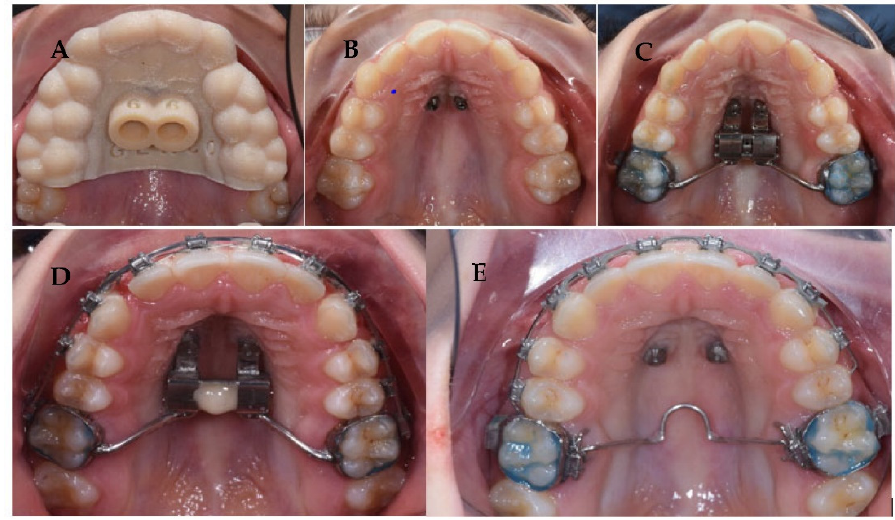
Figure 11. Treatment flow:( A ) Miniscrew guide fitting; ( B ) Occlusal view of miniscrew; ( C ) Appliance